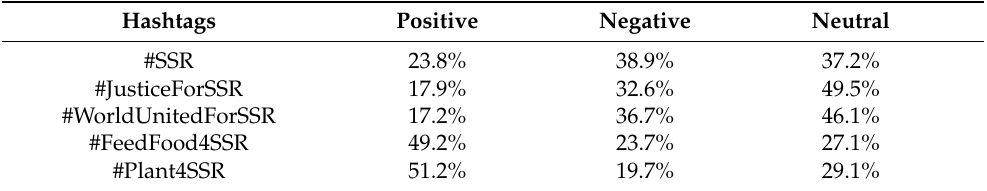
Table 6. Percentages of Sentiment Analysis.